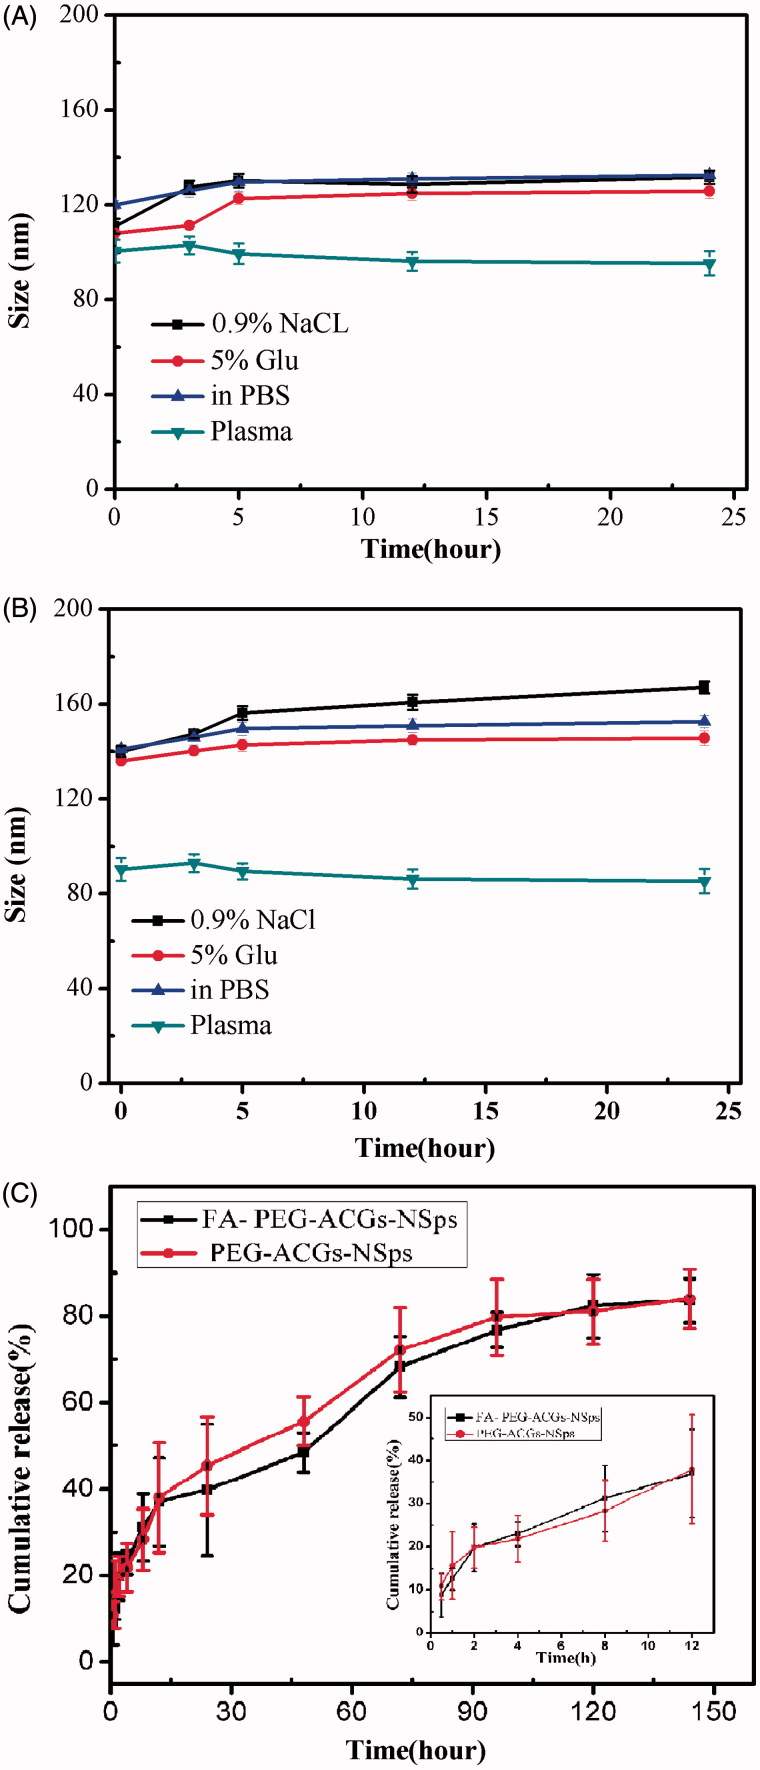
The stability and in vitro cumulative release profiles of ACGs-NSps. Particle size change of FA-PEG-ACGs-NSps (A) and PEG-ACGs-NSps (B) in 0.9% NaCl, 5% glucose, PBS, and plasma at 37 °C (n = 3, mean ± SD). (C) The in vitro cumulative release profiles of ACGs from FA-PEG-ACGs-NSps at 37 °C in pH 7.4 PBS. Notes: The amount of ACGs released from NSps was estimated by the reduction of quantity inside the dialysis bag with the HPLC method. All data are represented as mean ± SD (n = 3).